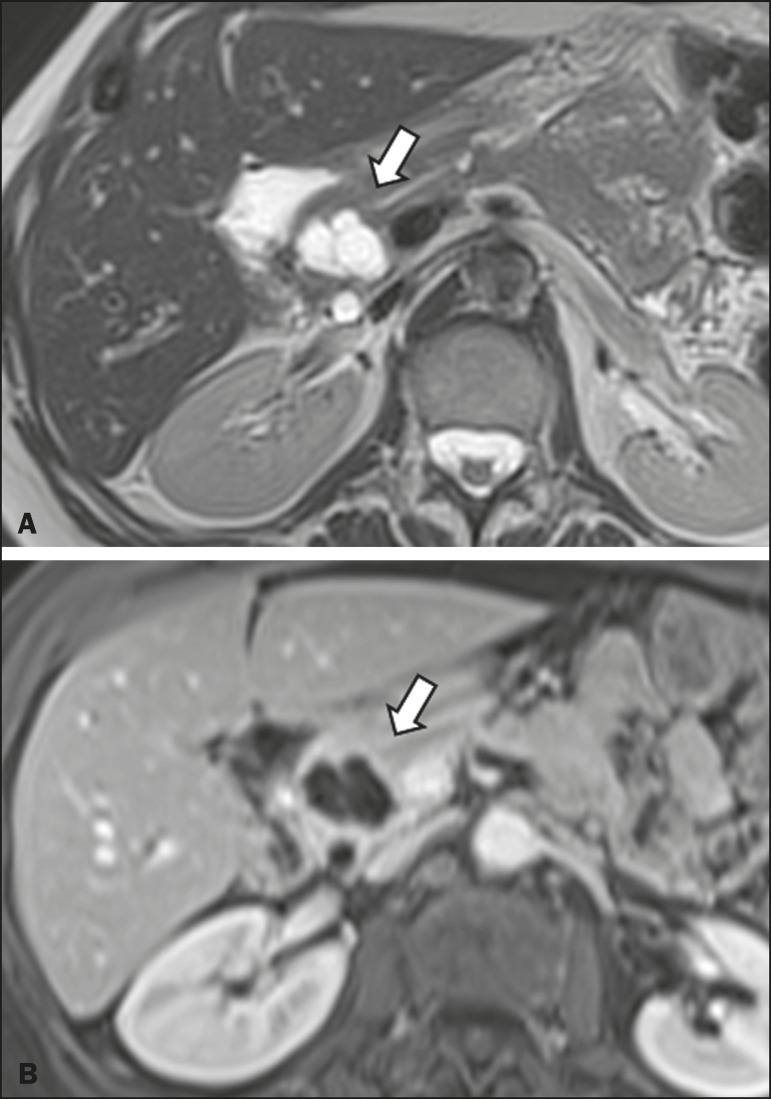
MRI scans. T2-weighted sequence (A) and contrast-enhanced
T1- weighted sequence (B), showing a multilocular cystic
lesion in the head ofthe pancreas, with fine septations and the
appearance of a serous cystic neoplasm (arrows).